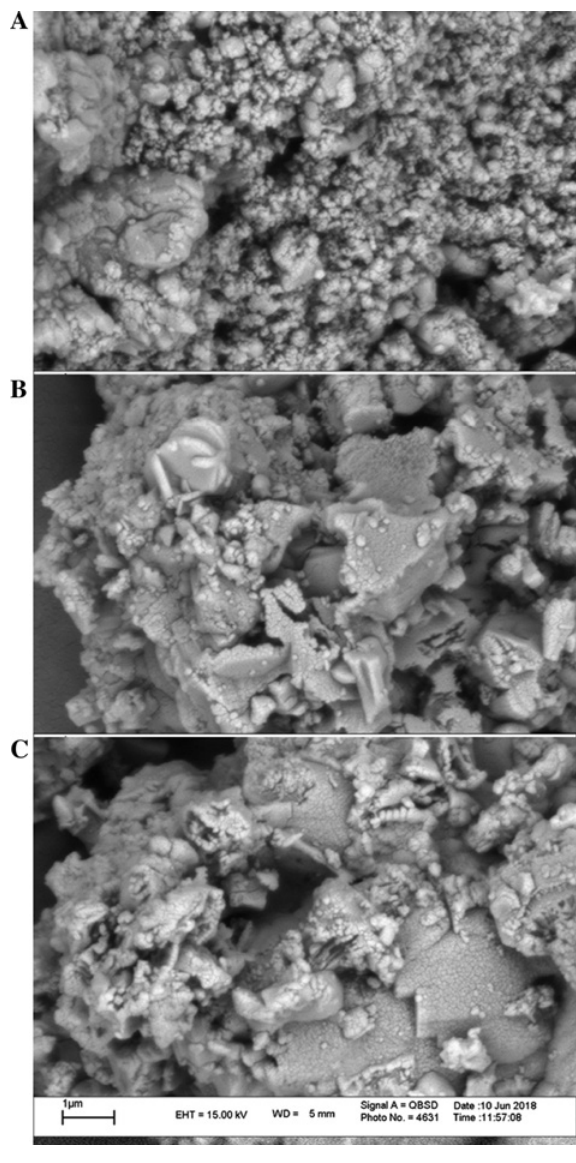
Figure 3: SEM images for the fabricated ZnO NPs using Pelargonium leaf extract and three heating methods, namely, conventional heating (heater-stirrer) (A), autoclave (B), and microwave irradiation (C). Table 1: Diameter of clear zones (mm) around the synthesized ZnO NPs using Pelargonium leaf extract and three heating methods, namely, conventional heating (heater-stirrer), autoclave, and microwave irradiation, is